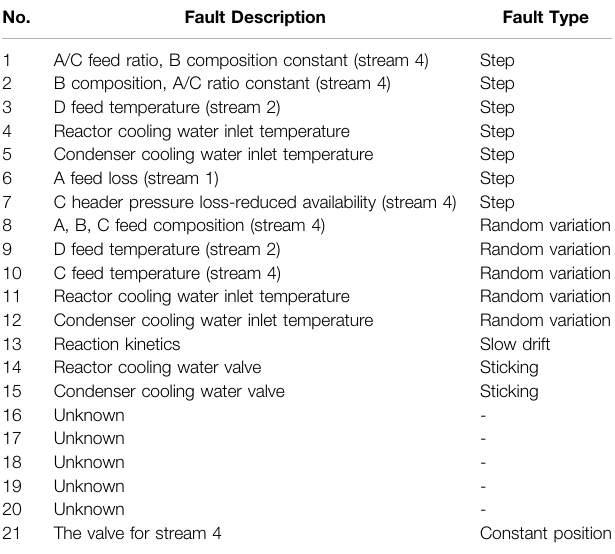
TABLE 2 | Faults in Tennessee Eastman Process.